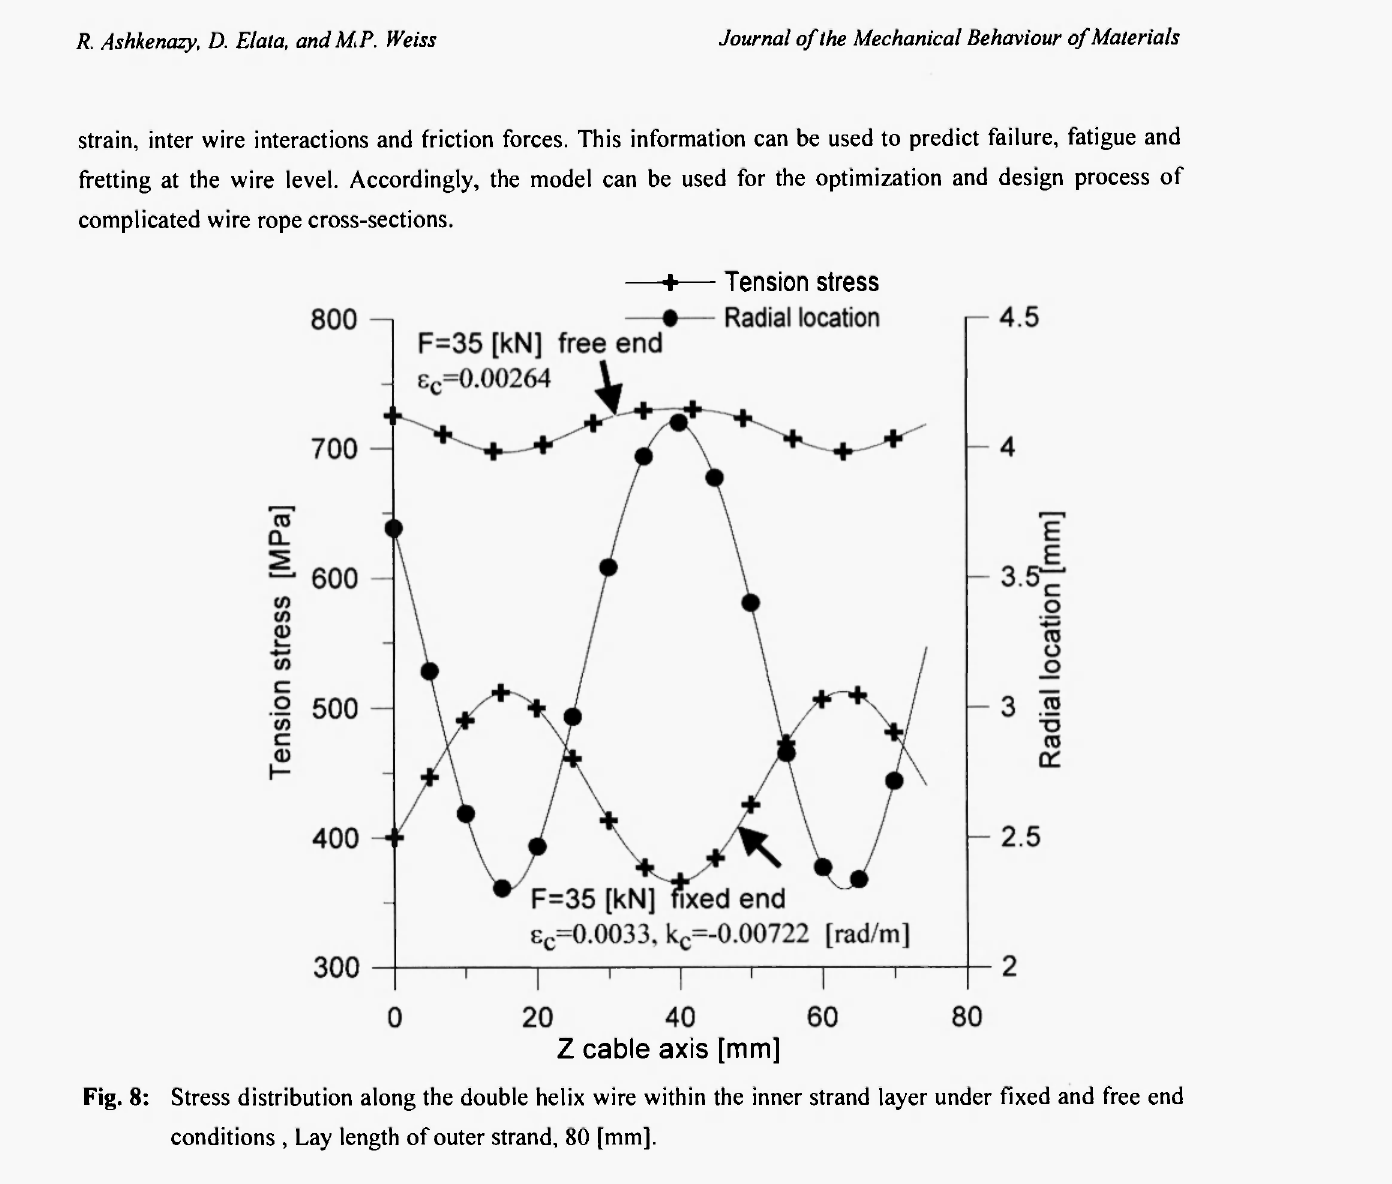
Fig. 8: Stress distribution along the double helix wire within the inner strand layer under fixed and free end conditions , Lay length of outer strand, 80